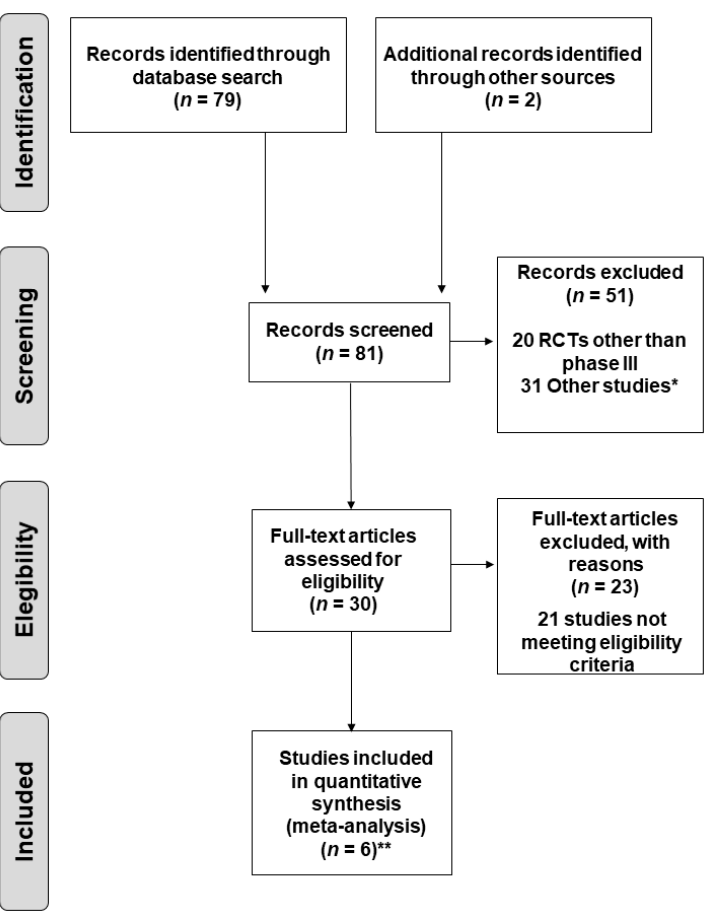
Figure 1. Flow chart of study selection (up to 1 November 2020). RCTs, randomized controlled trials * Other studies included pooled analyses, post-marketing studies, clinical trial protocols, patient-reported outcome assessments and any study on biomarkers/gene profiling. ** Two publi- cations (one of them presented at the ASCO congress) were included for one of the trials (KEY- NOTE-024 [10,33]).